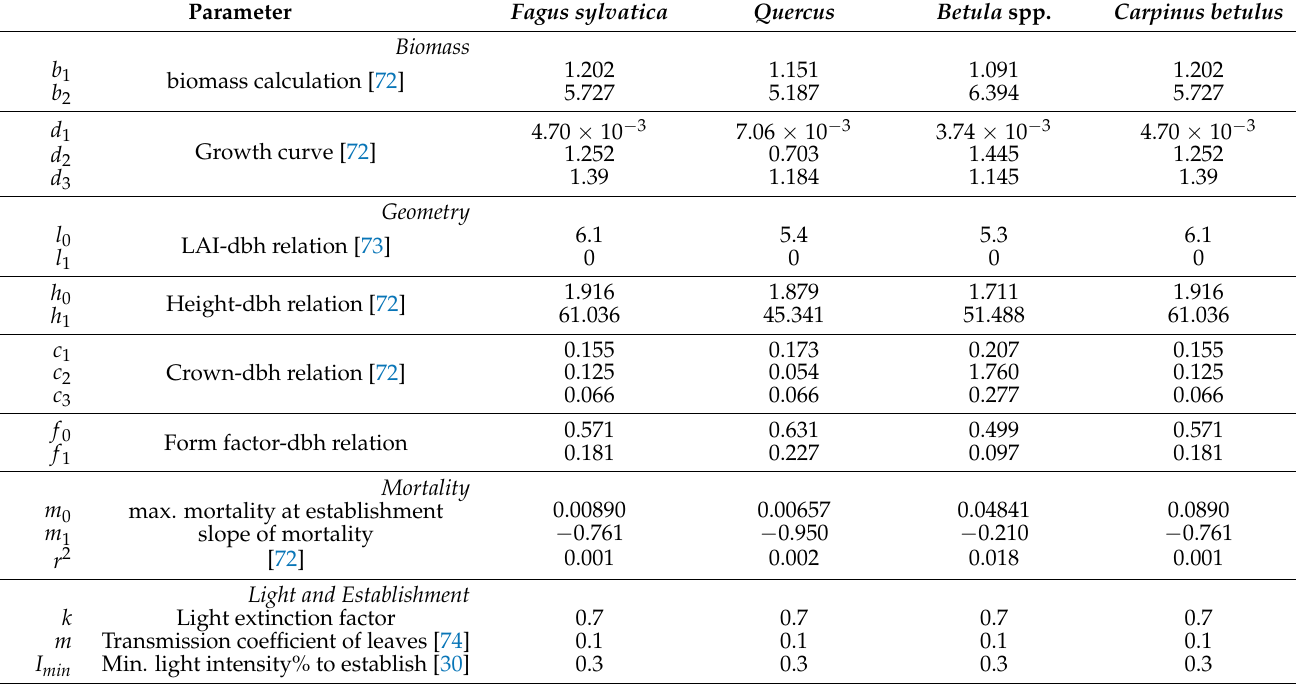
Table A3. Summary of the species-specific parameters taken from Bohn (2014) [30]. Parameter Fagus sylvatica Quercus Betula spp. Carpinus betulus Biomass b